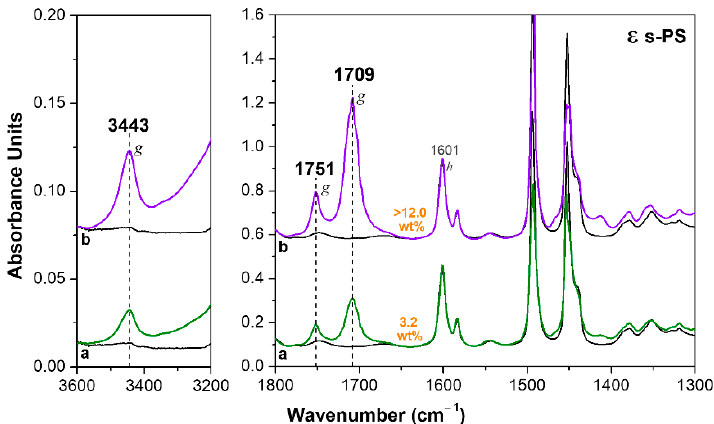
Figure 4. FTIR spectra of an axially oriented ε form s-PS film, after immersion in a 40 wt% solution of HA in acetone at room temperature: ( a ) for 10 min; ( b ) for 2 h. The uptake of HA in the film (expressed as wt%) is indicated close to the spectra.